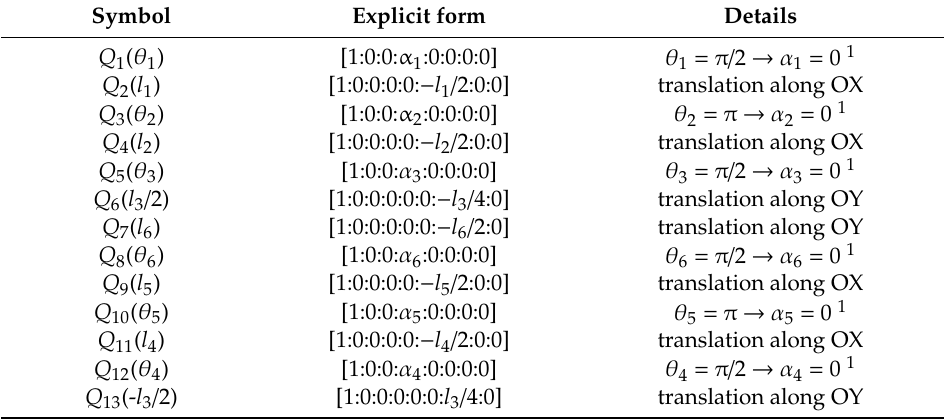
Table 1. The Study parameters used in the motion parameterization of the 6R mechanism. Symbol Explicit form